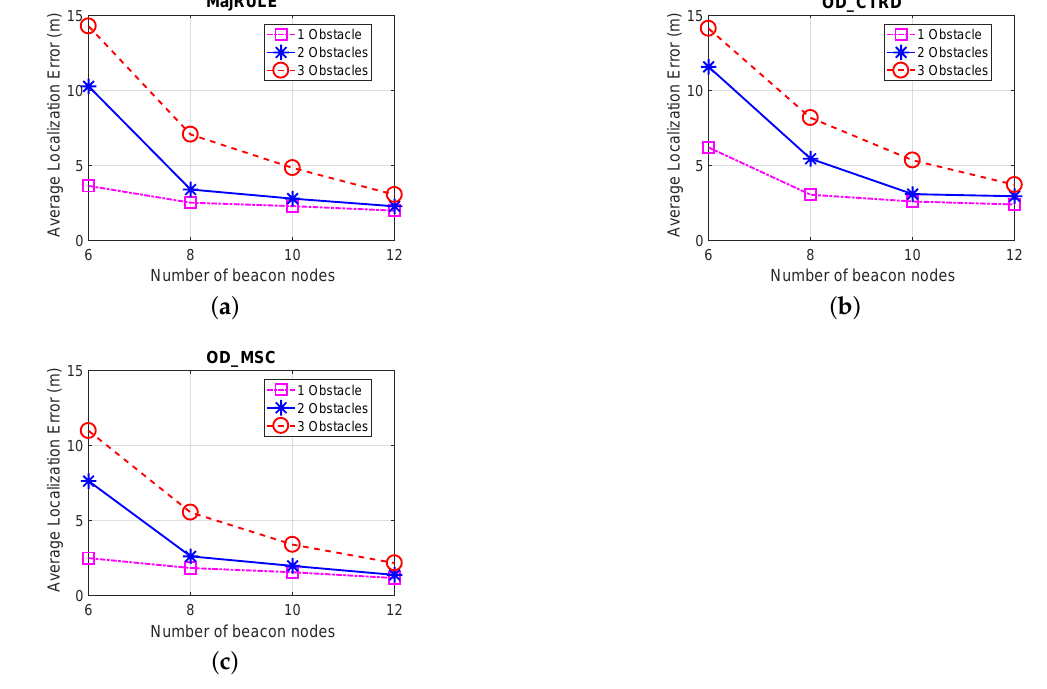
Figure 14. Shows the effect of the number of beacon nodes (( a ) MajRULE, ( b ) OD_CTRD, ( c ) OD_MSC) on localization accuracy